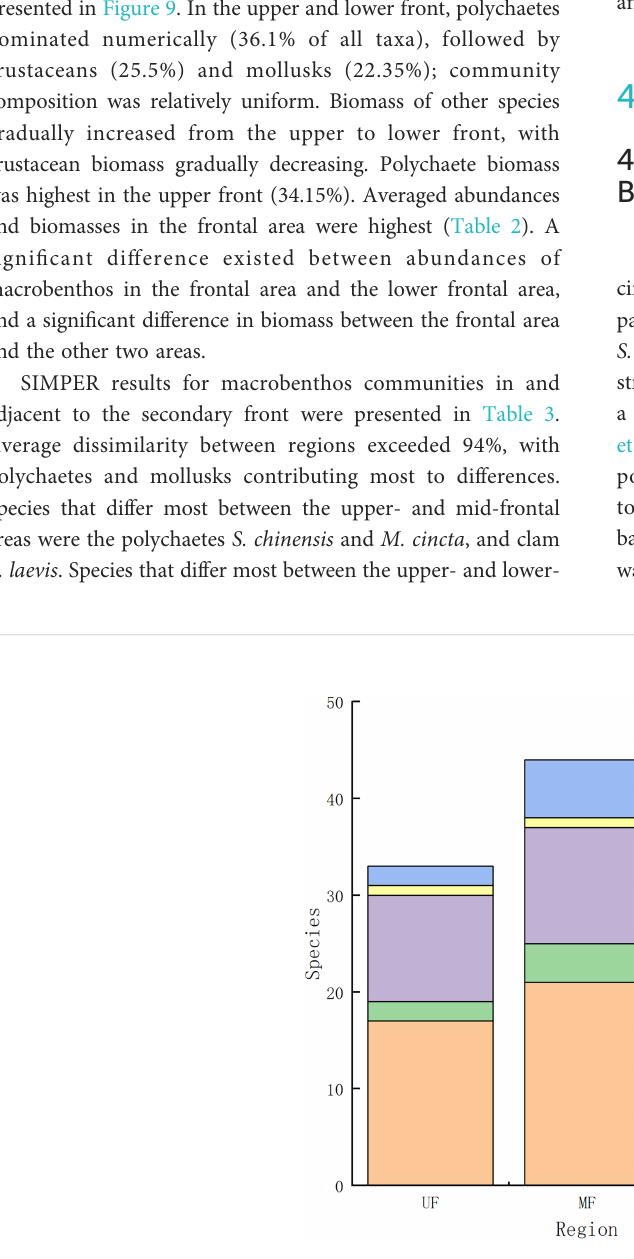
FIGURE 8 Macrobenthos composition in and adjacent to the secondary front, Hangzhou Bay. (UF, upper front; MF, middle front; LF, lower